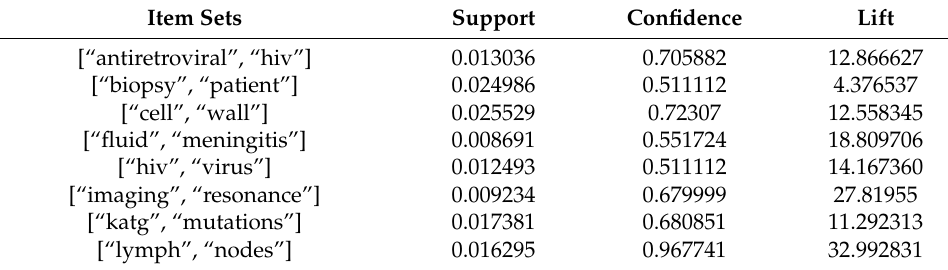
Table 5. Sample item sets of ethambutol dataset.